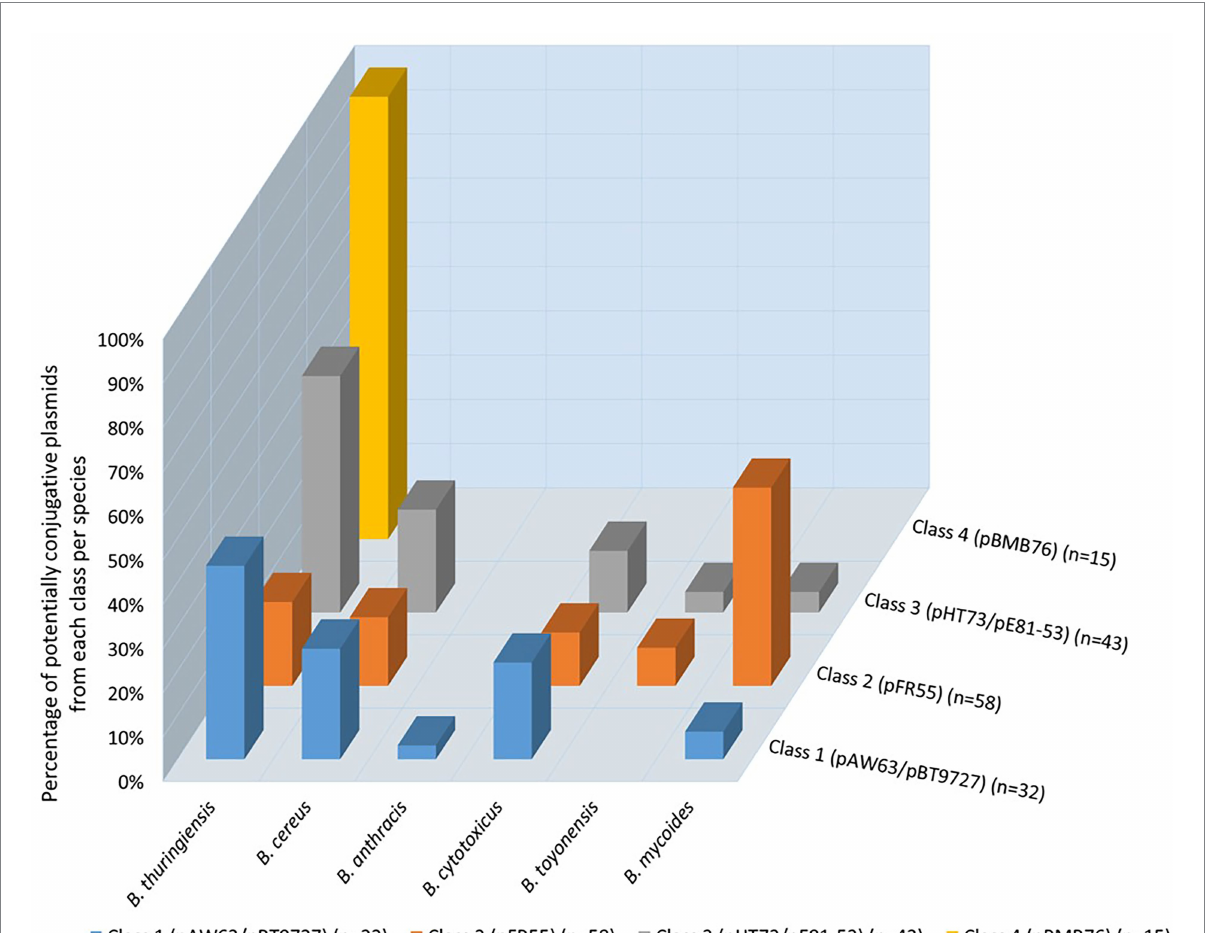
FIGURE 4 Distribution of potentially conjugative plasmids per species based on the four conjugative models (four classes). No hits were obtained with B. weihenstephanensis and B. pseudomycoides . Each bar shows the percentage of potentially conjugative plasmids identified based on the conjugative model of each of the four classes in the corresponding species. The total number of potentially conjugative plasmids identified is shown in parenthesis next to the corresponding